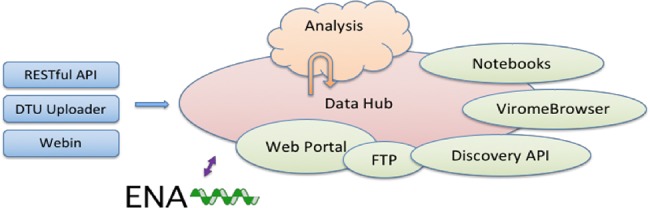
System architecture.